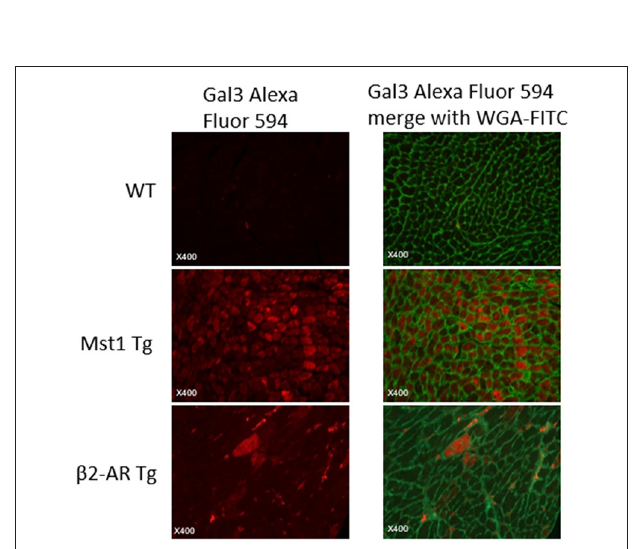
FIGURE 2 | Immunofluorescent staining of LV sections from wild-type, Mst1-Tg, and β 2-AR-Tg hearts in mice. Gal-3 staining: red fluorescence. Merged images also show cell boundaries in green (i.e., wheat-germ agglutinin-FITC staining).